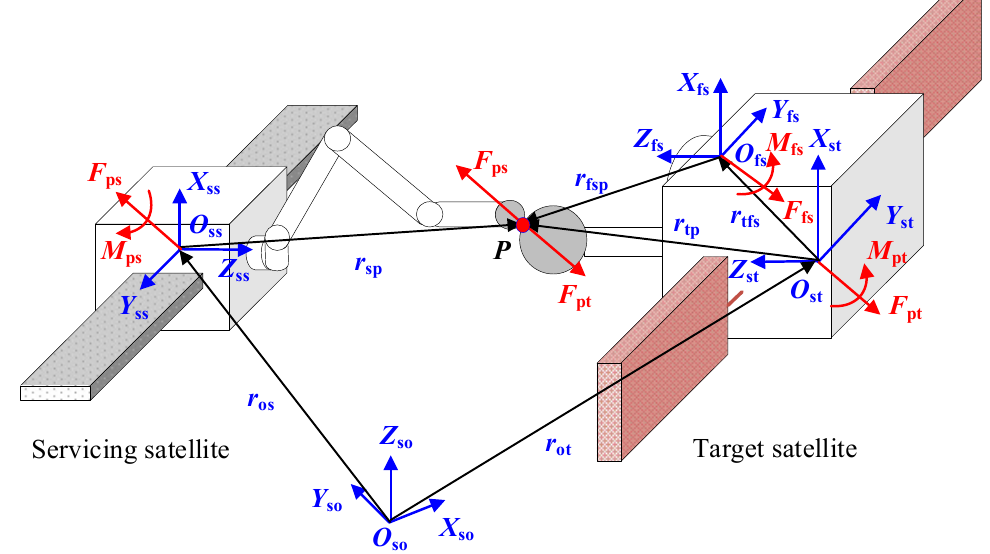
Figure 5. Coordinate systems and force analysis for free-floating satellites.